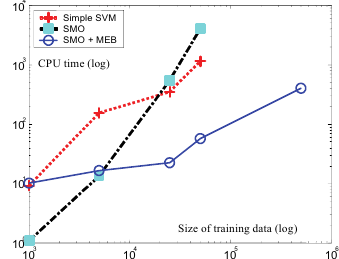
Figure 6. Example 1: running time vs training